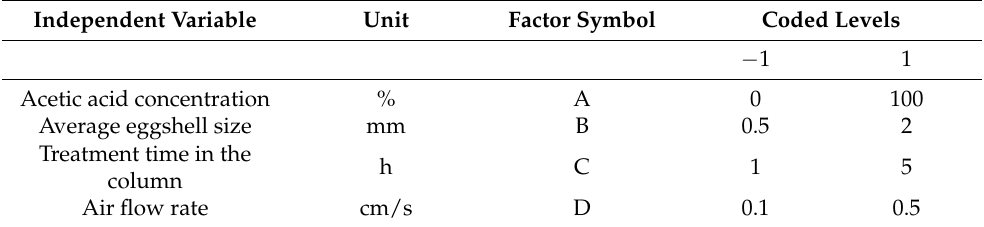
Table 1. Independent variables and their levels used for Central Composite Design